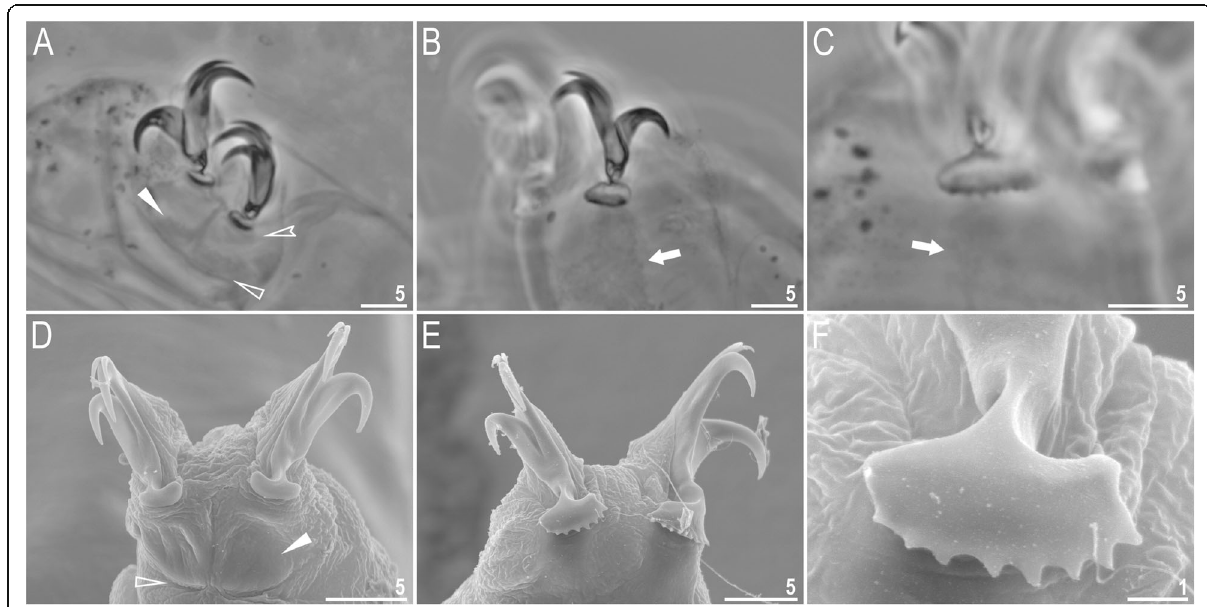
Fig. 24 Macrobiotus ripperi sp. nov. from Poland (PL.015) – claw morphology: a – b – claws II and IV seen with LCM; c – magnification of lunulae IV seen with LCM; d – e – claws I and IV seen with SEM; f – magnification of lunulae IV seen with SEM. Empty indented arrowhead indicates dark circular areas under lunulae on the first three pairs of legs, filled flat arrowheads indicate cuticular bar above muscle attachments, empty flat arrowheads indicate double muscle attachments under claws, arrows indicate horseshoe structure connecting the anterior and the posterior claw. Scale bars in μ m